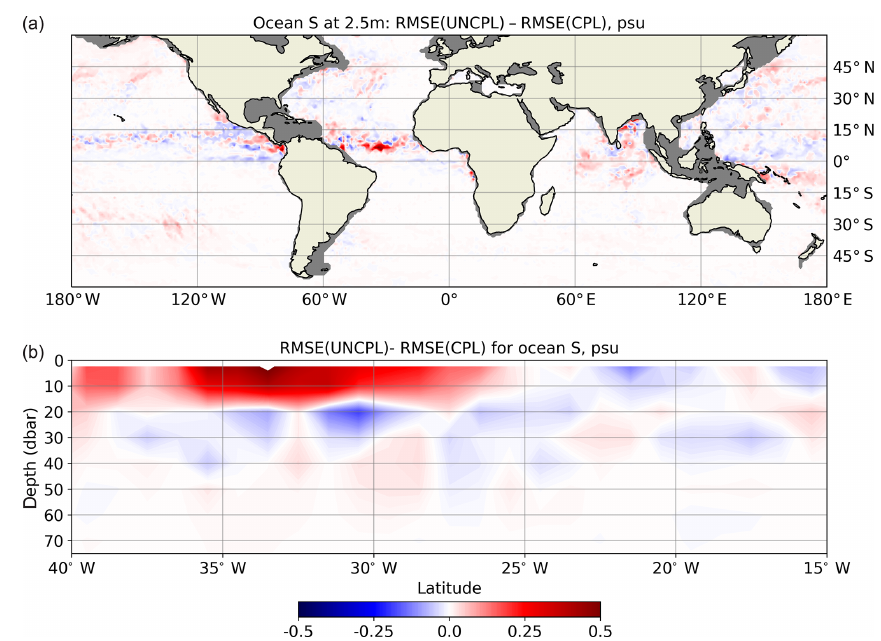
Figure 14. Difference between the UNCPL and CPL (24h forecasts) RMSE (psu) with respect to the Argo ocean salinity measurements in September 2017. Positive values (red) indicate that the RMSE produced by CPL is smaller, whereas negative values (blue) mean the converse. (a) The RMSE difference for ocean salinity at 2.5m of depth. The grey areas show the regions where Argo measurements were not taken. (a) The salinity vertical section through 6.5 ◦ N latitude in the tropical Atlantic Ocean between 40 and 15 ◦